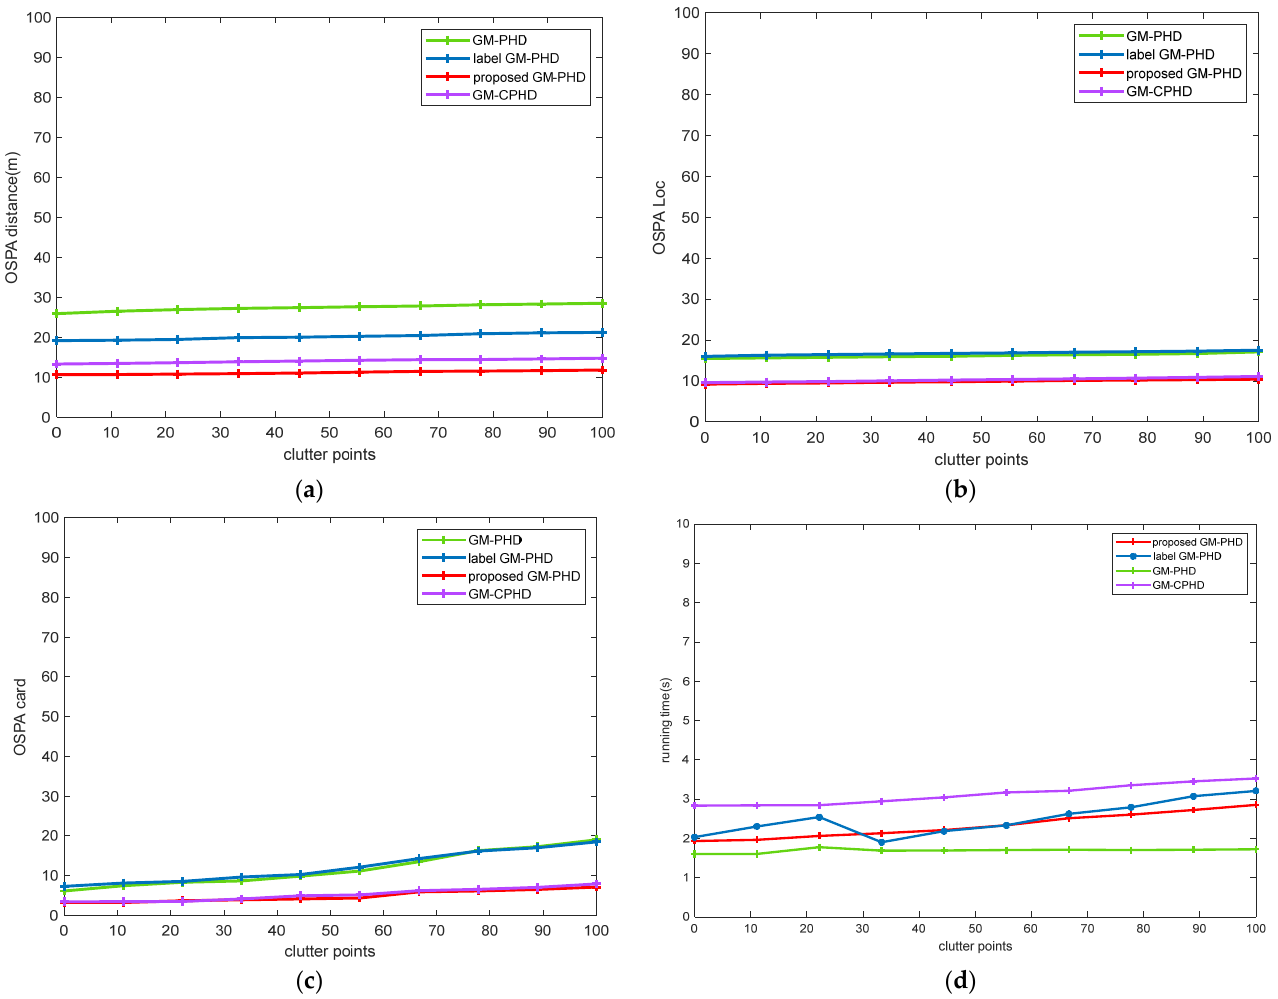
Figure 5. Comparison of the performance of different filters in a changing environment of clutter rate: ( a ) OSPA distance comparison; ( b ) OSPA Location comparison; ( c ) target cardinalities estimation error; ( d ) running time comparison.